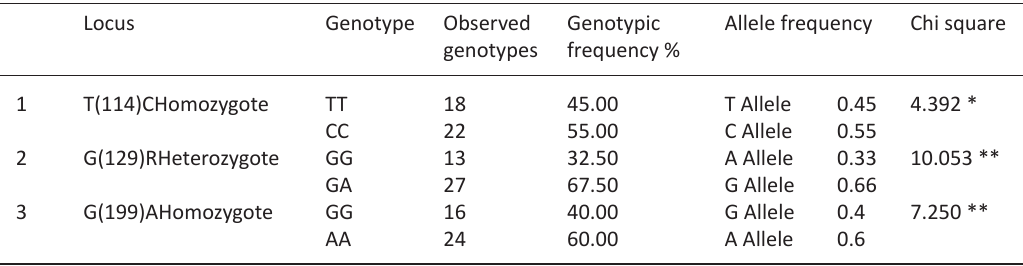
Table 2. Genotypesand alleles structure frequencies of exon I of GDF-9 gene locus for Awassi ewes Locus